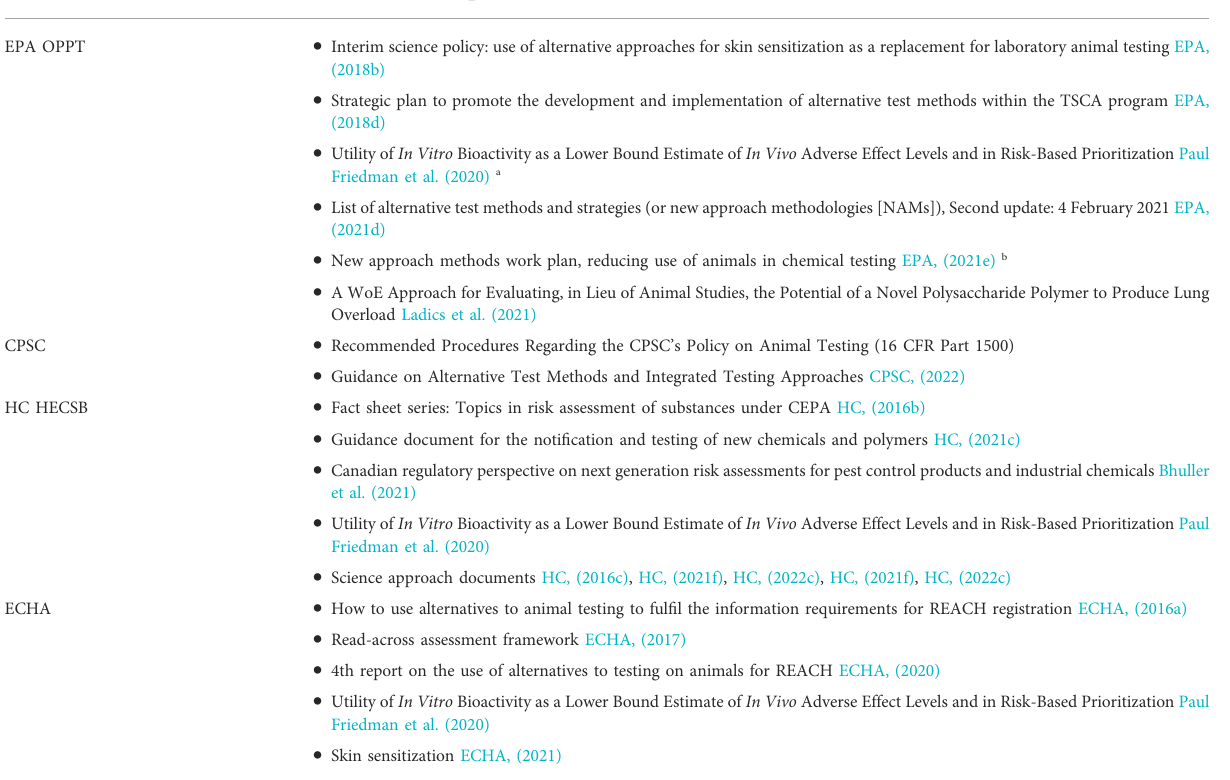
TABLE 1 US, Canada, and EU: industrial chemicals and household products. Agency Strategic plans, guidance, and other documentation for the implementation of NAMs referenced in this manuscript EPA